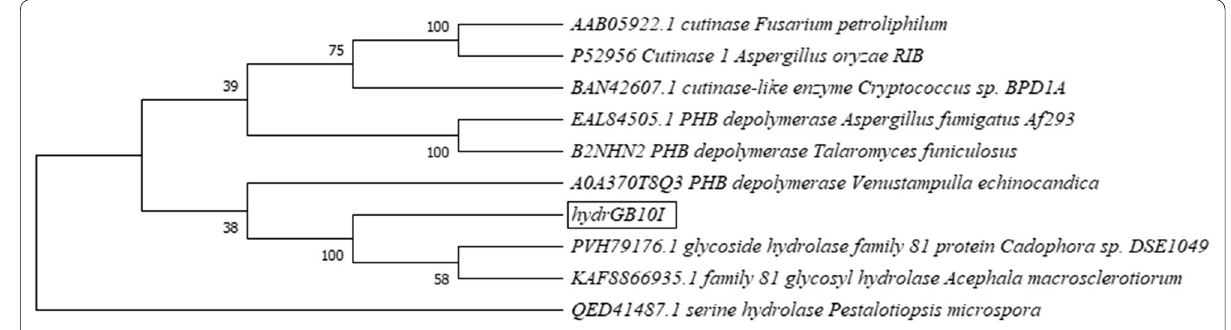
Fig. 5 Neighbour-joining tree of hydrGB10I ( Geomyces sp. B10I) and other enzymes with the biodegradation activity. The bootstrap consensus tree inferred from 1000 replicates and the percentage of replicate trees in which the associated taxa clustered together in the bootstrap test is shown next to the